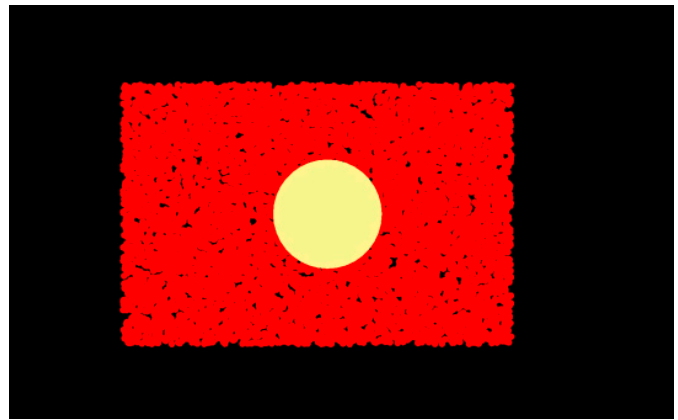
Figure 20. Initial morphology in the case of a simple monopile ( a ) Plan view, ( b ) Side view. J. Mar. Sci. Eng. 2020 , 8 , x FOR PEER REVIEW